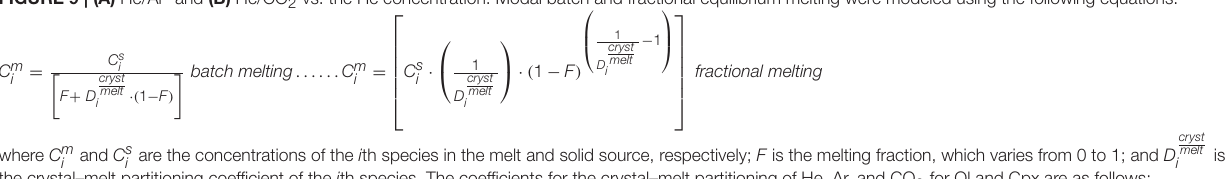
cryst melt i is − 4 , and Cpx / melt D He = 2 × 10 Ar = 1.1